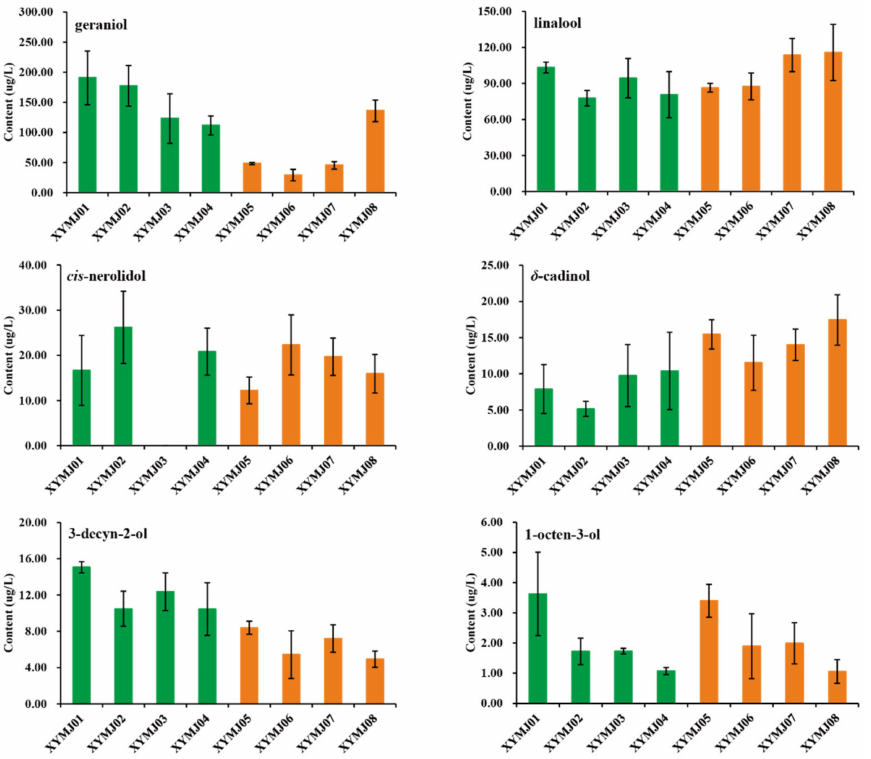
Figure 2. Various change trends of the alcohols in XYMJ green teas. All data are expressed as mean ± S.D. ( n = 3).